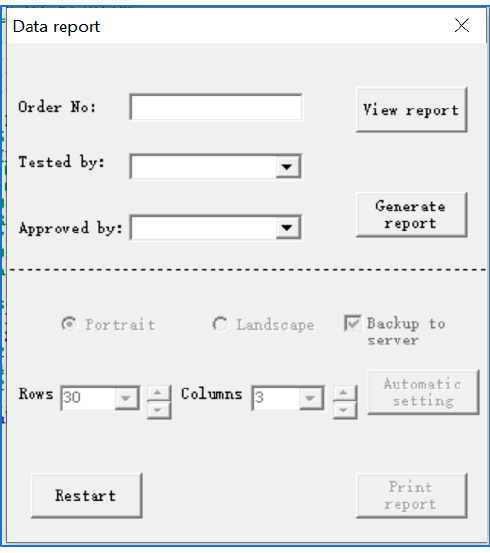
Figure 6. Automatic data report generation module.